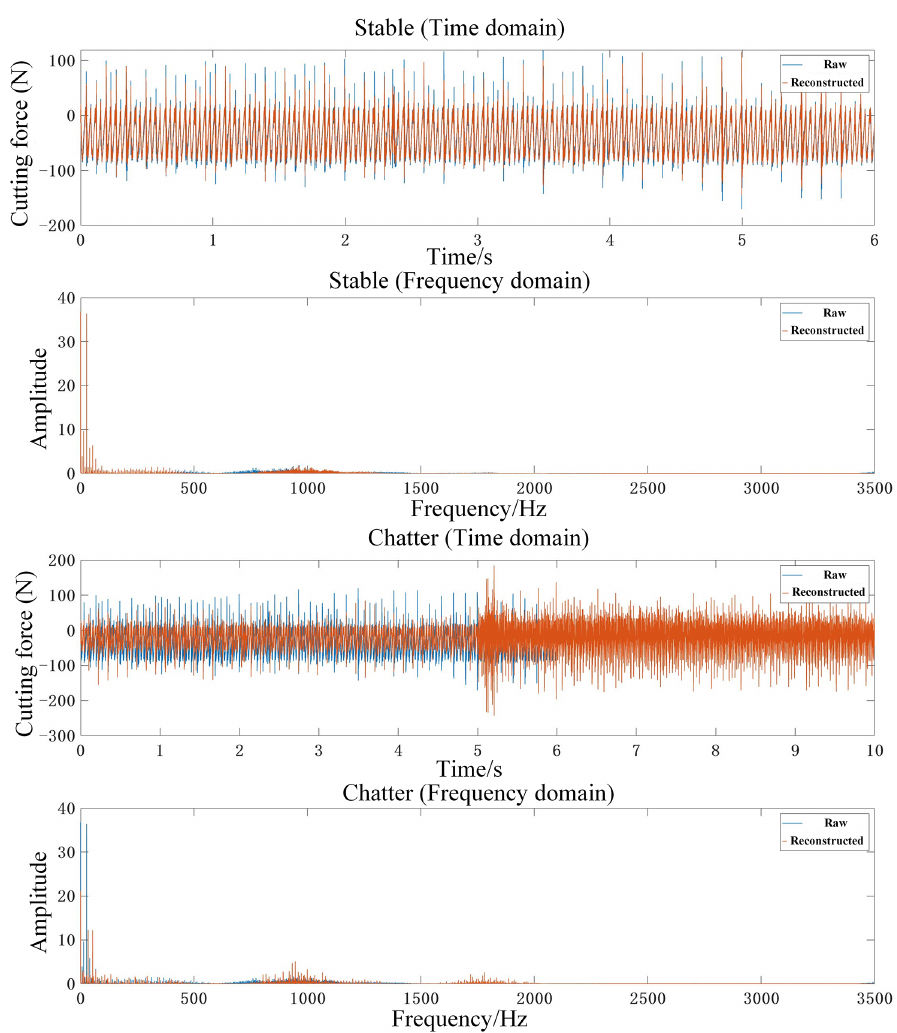
Figure 14. Time and frequency domain analysis of raw and reconstructed signals.